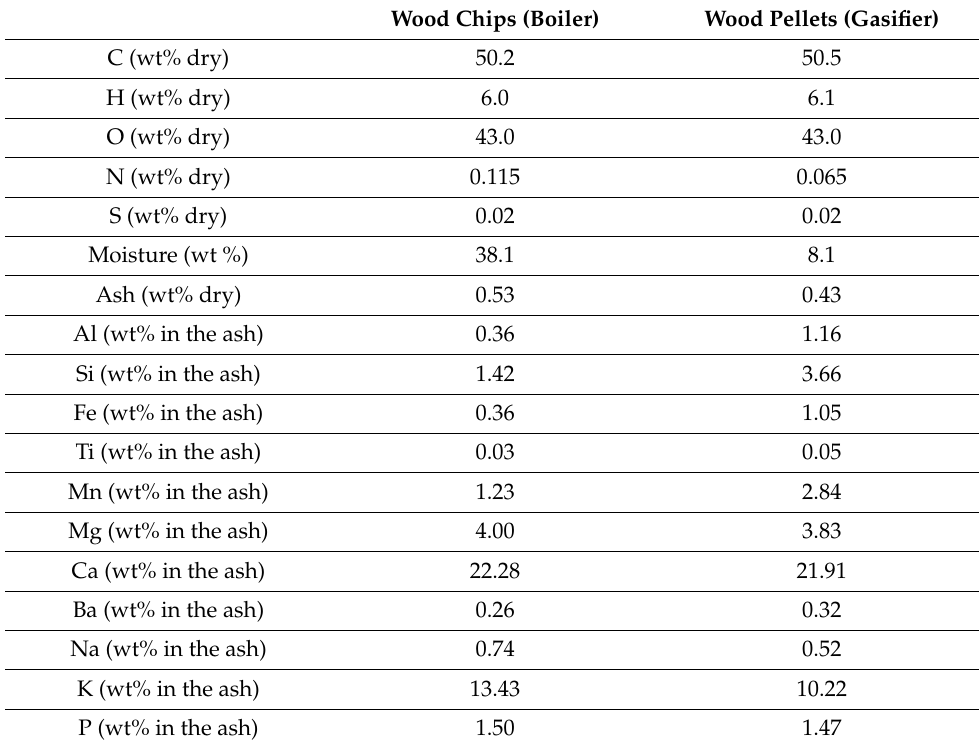
Table 1. Elemental analysis of the fuels used in the boiler and the gasifier. Wood Chips